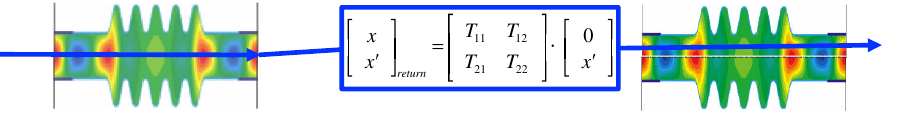
FIG. 2. A sketch of the driving mechanism of TBBU instability in